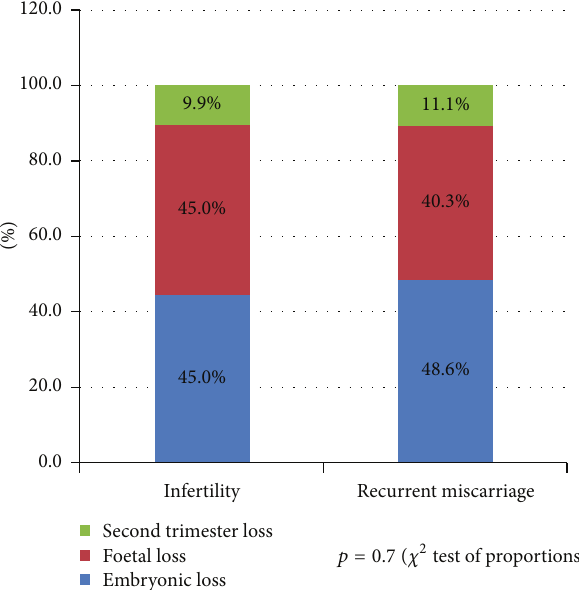
Figure 2: A comparison of the pattern of pregnancy loss between women with infertility and recurrent miscarriage.